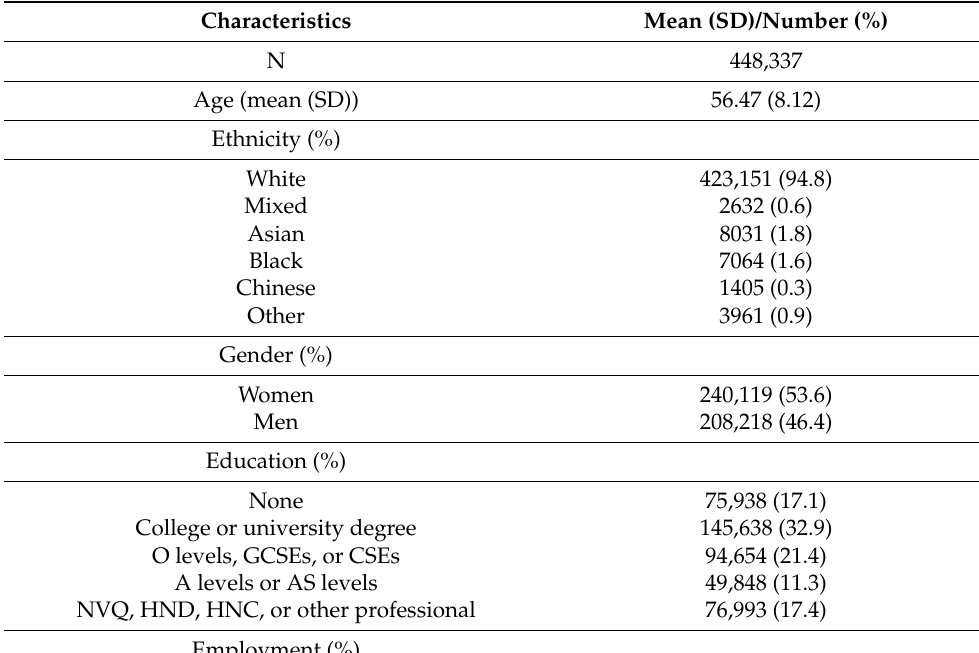
Table 1. Characteristics of the participants included (N =